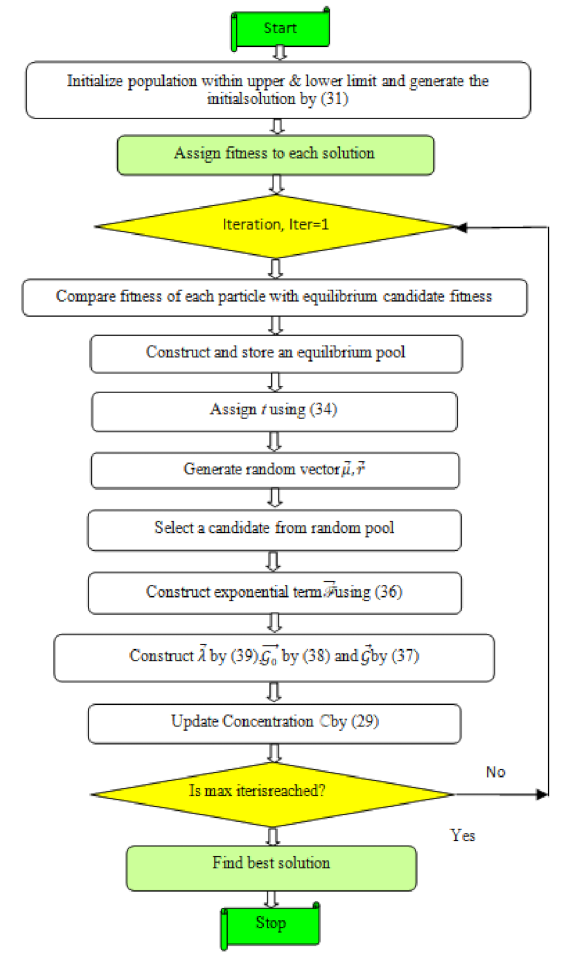
Figure 4. Flow chart of Equilibrium